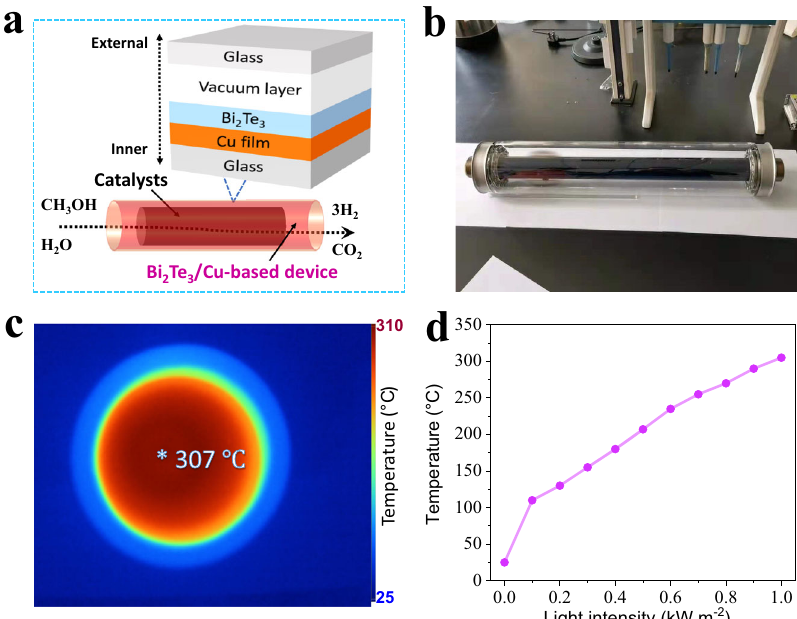
Fig. 3 Bi 2 Te 3 /Cu-based device. a Map of the Bi 2 Te 3 /Cu-based device loaded with catalysts for solar-heating MSR. b Photograph of the homemade Bi 2 Te 3 / Cu-based device. c Cross-sectional IR image of the Bi 2 Te 3 /Cu-based device under 1-sun irradiation. d Temperature of the CuZnAl catalyst loaded in the Bi 2 Te 3 /Cu-based device under different intensities of solar